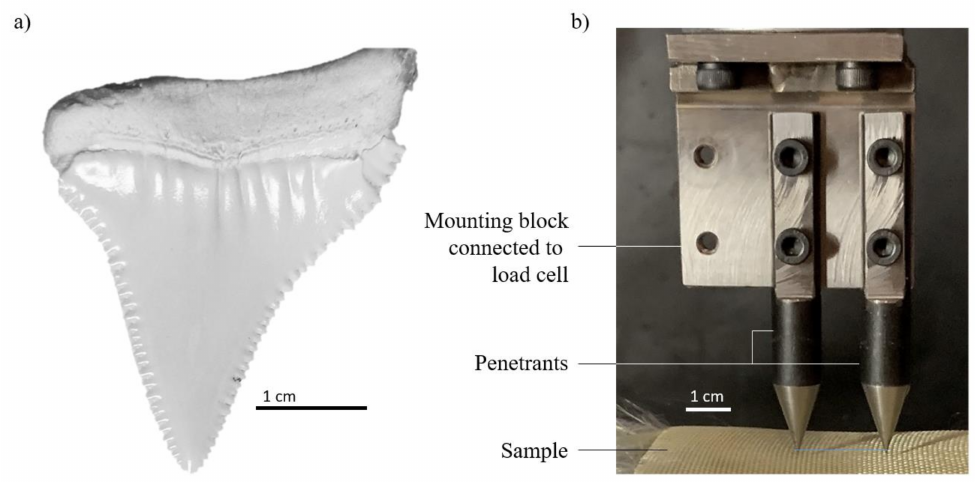
Figure 2. ( a ) Carcharodon carcharias tooth; ( b ) steel rod penetrants.